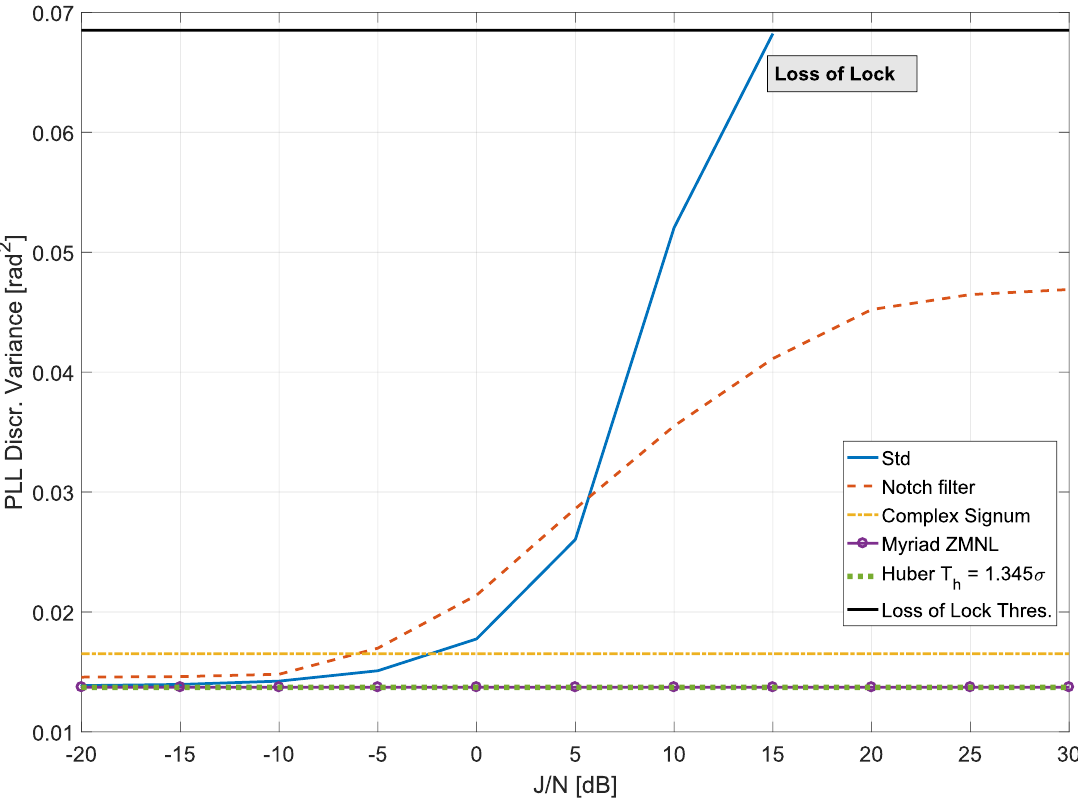
Figure 4. Variance of the PLL discriminator versus J / N of a CW interference. Comparison of standard (no anti-jamming) processing, adaptive notch filtering, complex signum ZMNL, myriad ZMNL and Huber’s